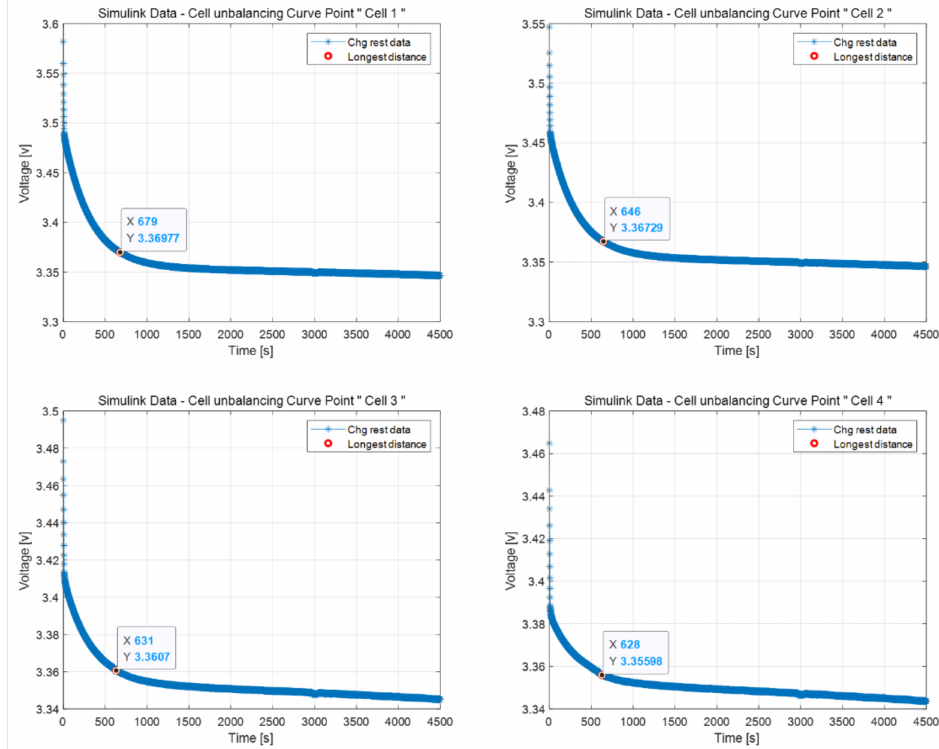
Figure 12. Curve point with cell balancing